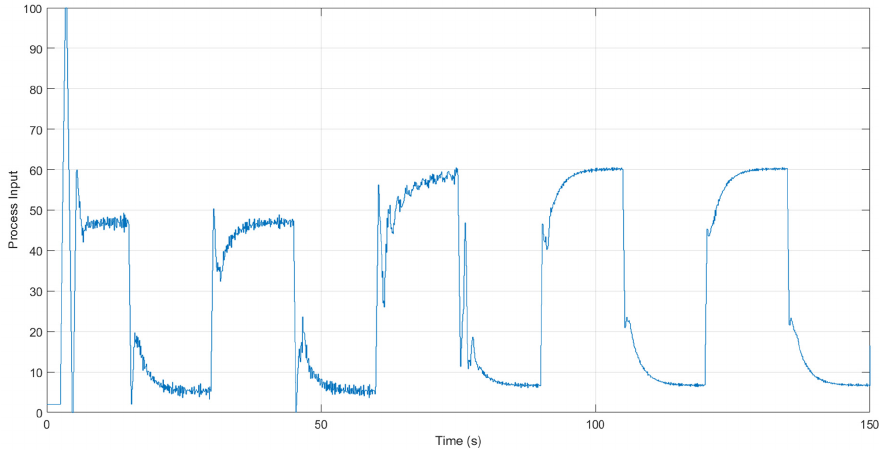
Figure 10. Applied controls (process input) in the constrained case. Electronics 2017 , 6 , 88